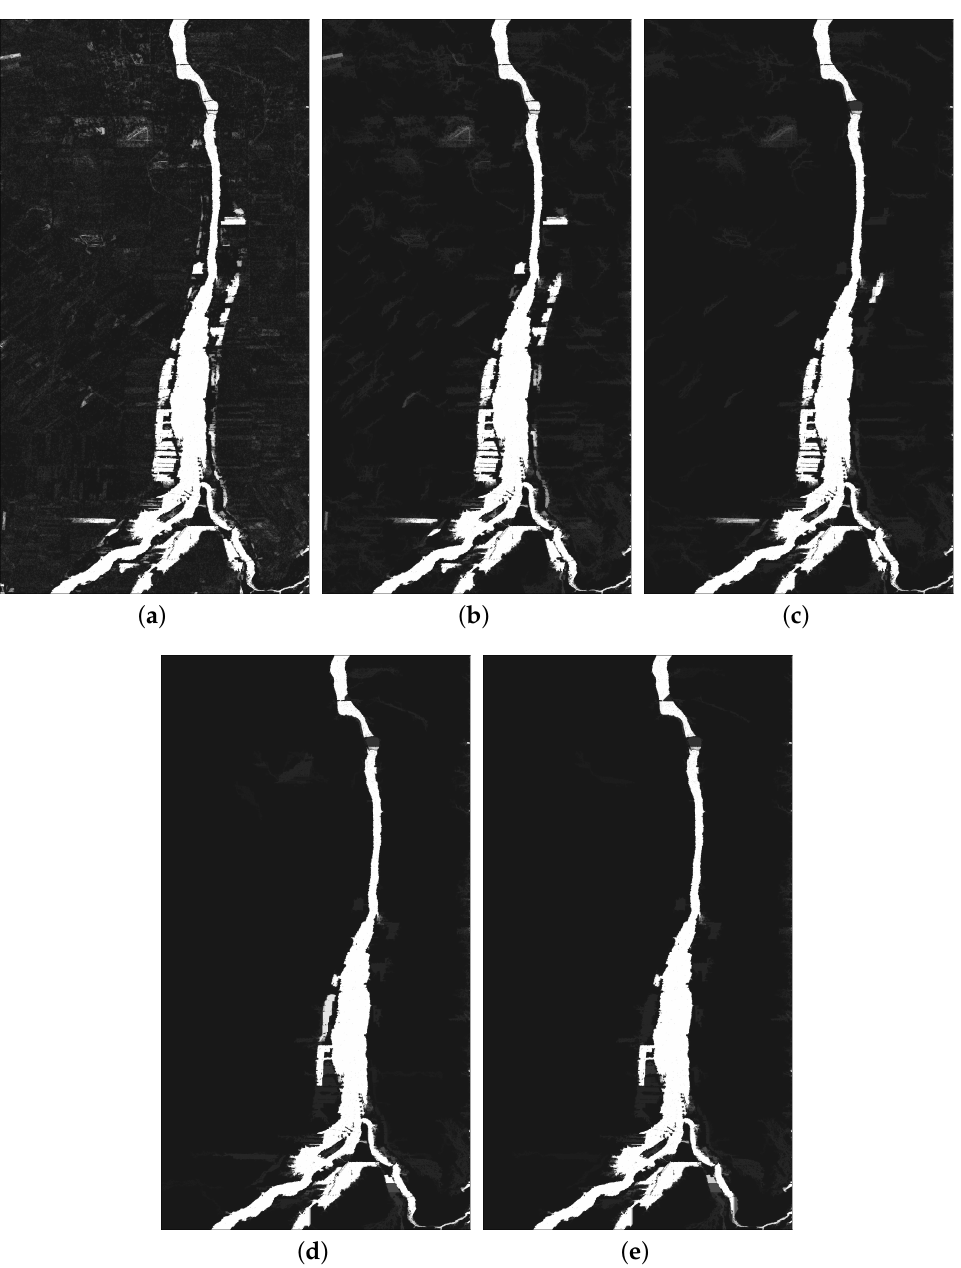
Figure 6. Results of the paths-opening operator with increasing structuring element applied to the post-flooding image (we added some contrast to improve the display). ( a ) Original input image; ( b ) L min = 50; ( c ) L min = 100; ( d ) L min = 150; ( e ) L min =